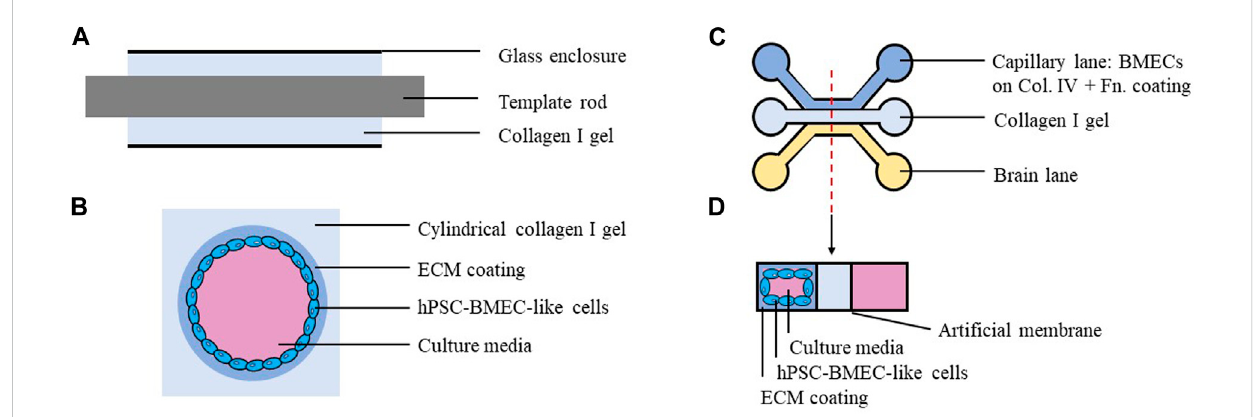
FIGURE 3 Schematicsofthree-dimensionalmodelsbuilt withhPSC-BMEClikecells. (A) Sideview ofthecollagenIgelduring modelconstruction. Neutralized collagen I was injected into glass enclosure around a template rod. (B) Cross-sectional view of fi nished model. The cylindrical gel was treated with ECM coating solutions, then seeded with hPSC-derived BMEC-like cells. (C) One well in the OrganoPlate 3-lane plate (with 40 clusters of 9 wells on each plate). (D) Cross-sectional view of the fi nished model. Three lanes are separated by arti fi cial membranes. Capillary lane was coated with collagen IV and fi bronectin, then seeded with hPSC-derived BMEC-like cells. The middle lane was fi lled with collagen I